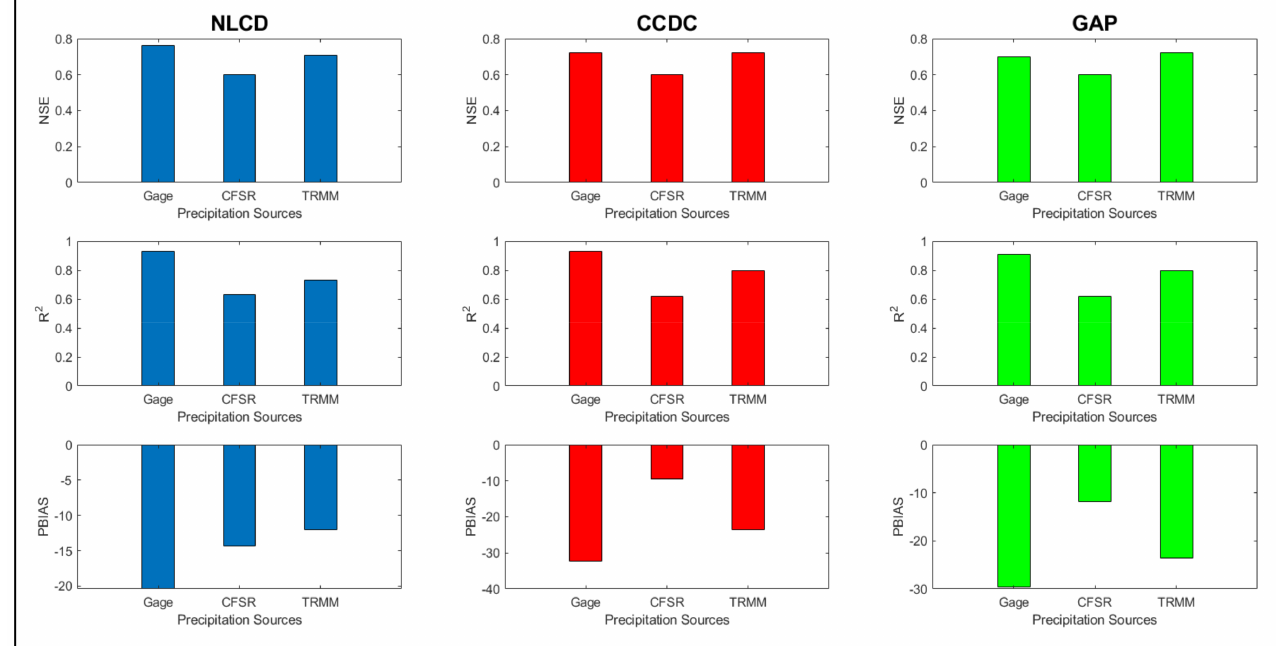
Figure 10. Model performance with various LULC and precipitation dataset combinations for the SRTM DEM based on NSE, R 2 , and PBIAS